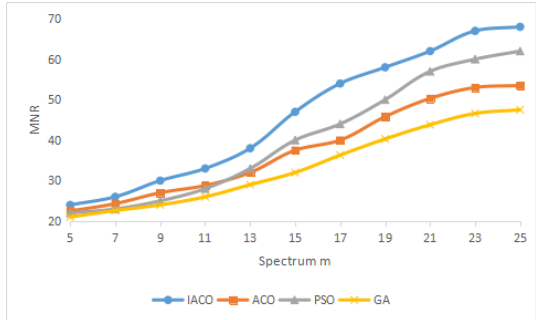
Figure 7. MMR change with N =